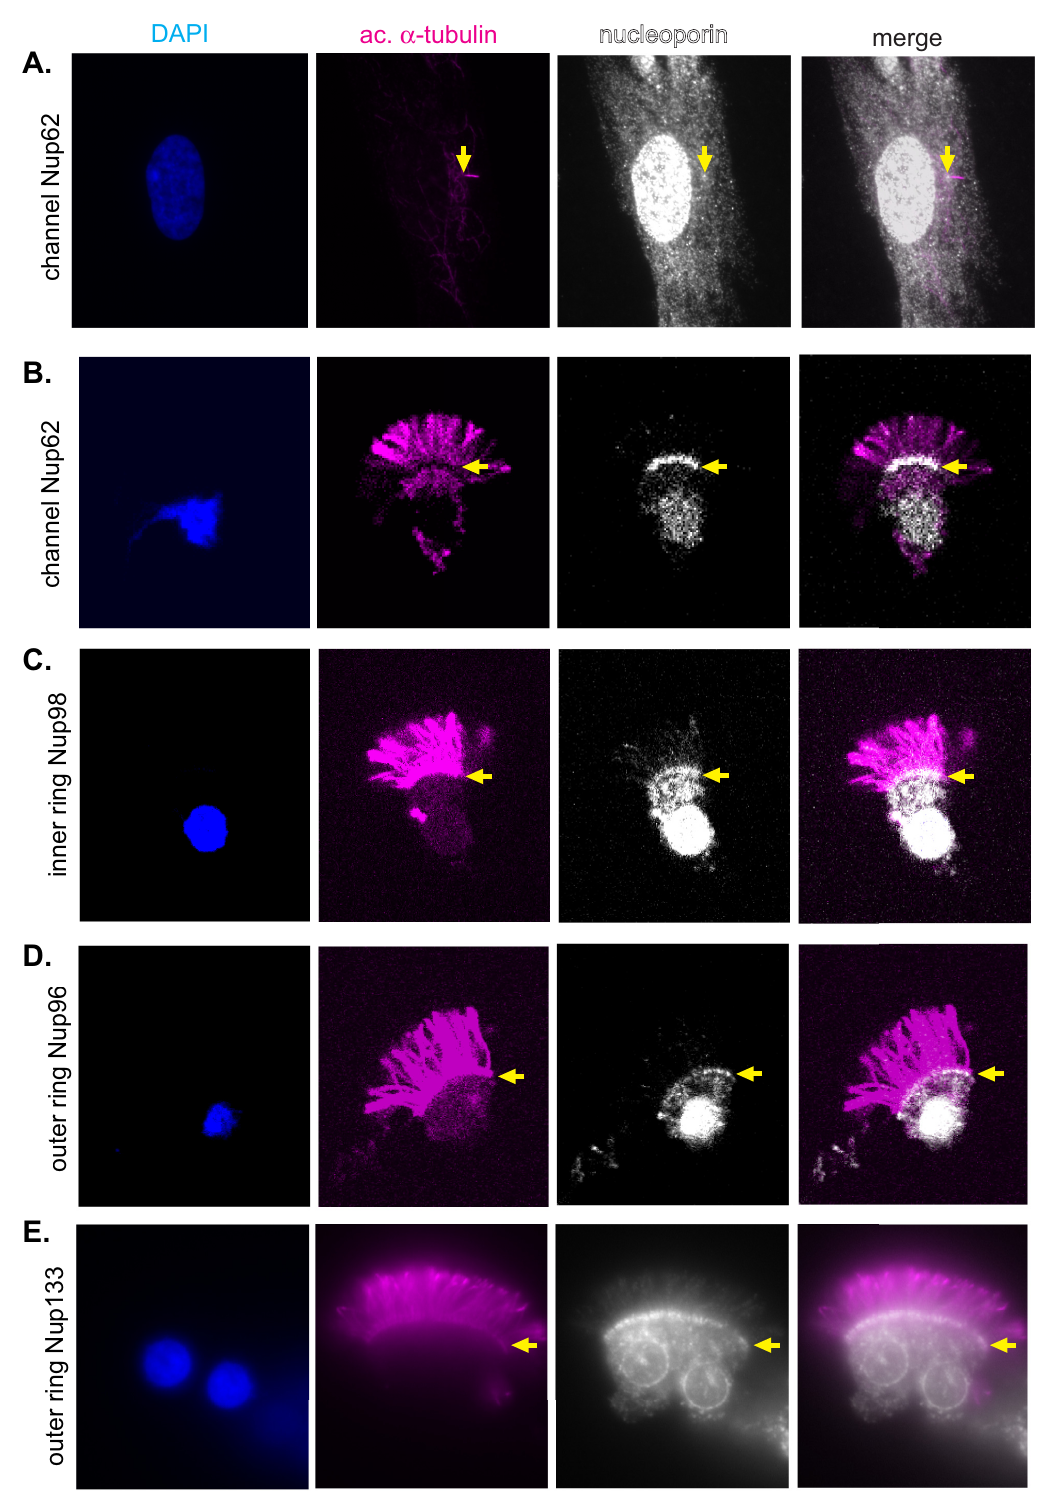
Fig 2. Inner ring, outer ring, and central channel nucleoporins localize to the base of motile cilia. (A) RPE-1 cells were stained with antibodies to the channel nucleoporin Nup62 (gray). (B-E) Epithelial cells isolated from rat trachea were stained with antibodies against (b) the channel nucleoporin Nup62, (C) the inner ring nucleoporin Nup98, or the outer ring nucleoporins